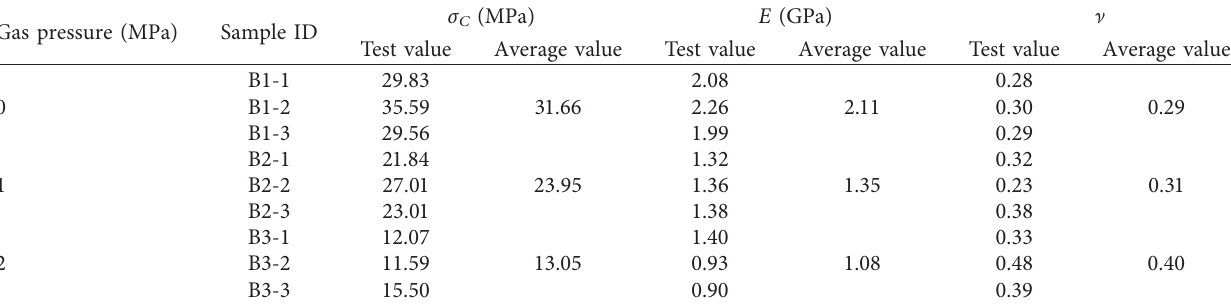
Figure 7: Relationship between UCS, elastic modulus, and gas pressure. Table 5: Results of the mechanical property of coal samples under different gas pressures.